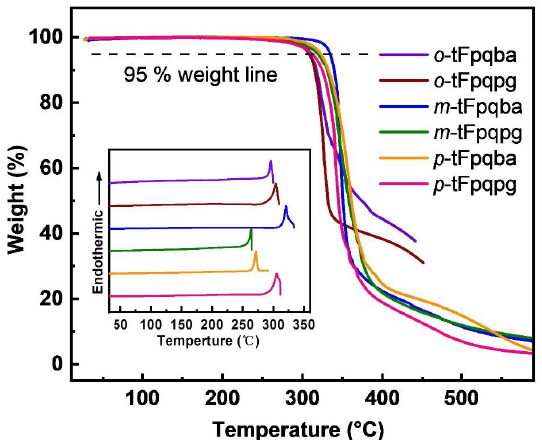
Figure 3. Thermal analyses for all complexes: TGA and DSC (inset) thermograms.